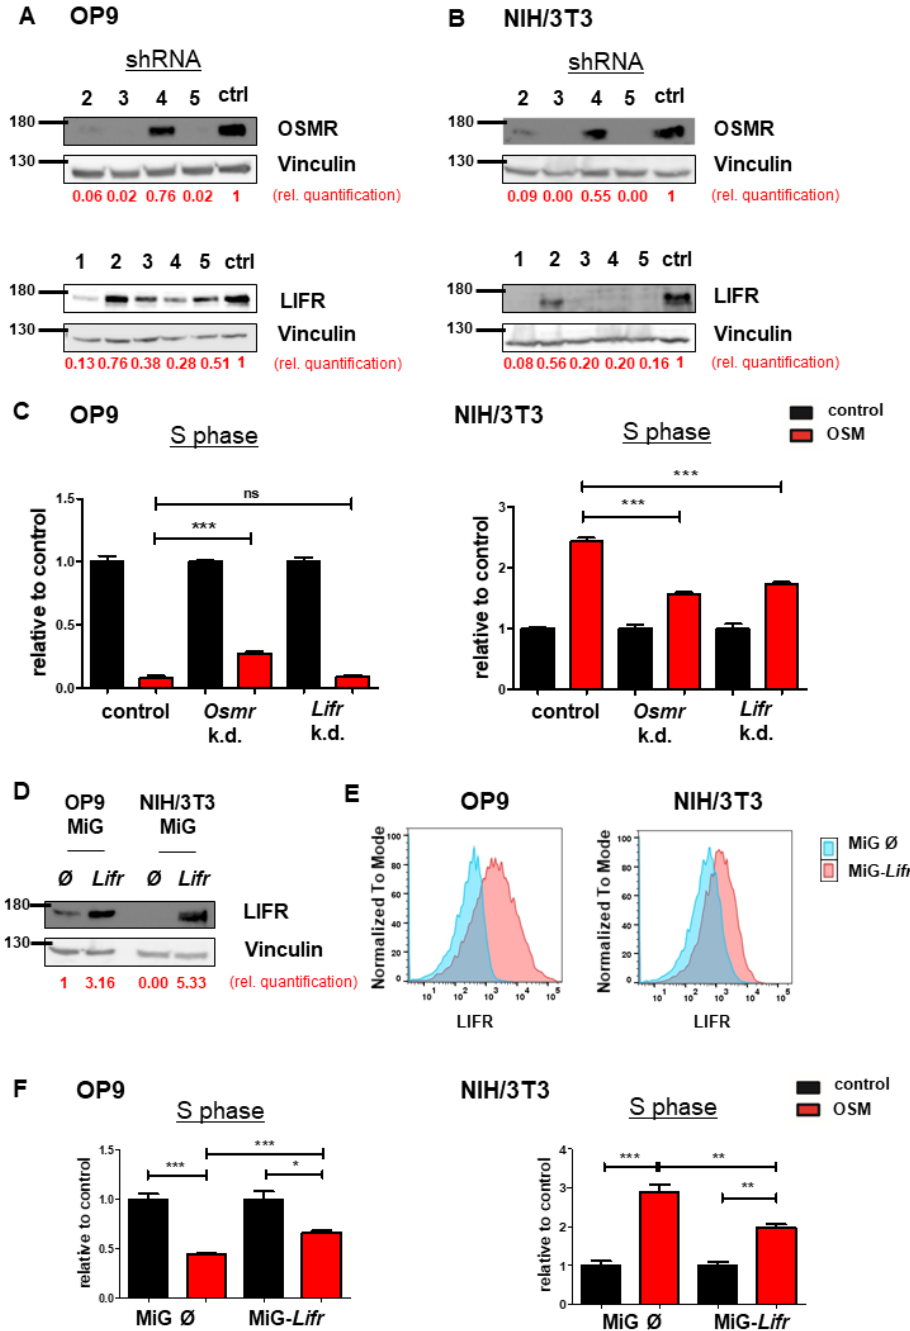
Figure 3. OSMR downregulation attenuates OSM effects on proliferation. ( A , B ) Immunoblot quantifying the shRNA-induced knockdown of Osmr (n = 4) and Lifr (n = 5) in ( A ) OP9 and ( B ) NIH/3T3 cells. The shRNAs Osmr 5 and Lifr 1 were used in subsequent experiments. Protein molecular weight is labeled in kDa. Relative protein quantities are indicated in red. ( C ) Relative quantification of S phase of OP9 and NIH/3T3 cells carrying a knockdown for either Osmr , Lifr, or a Renilla control in presence or absence of 10 ng/mL mOSM. Cell cycle analysis was performed as described before. One-way ANOVA and Bonferroni post-test. *** p < 0.001. ns = not significant. ( D ) Immunoblot quantifying the LIFR overexpression in OP9 and NIH/3T3 cells. Protein molecular weight is labeled in kDa. Relative protein quantities are indicated in red. ( E ) Lifr overexpressing OP9 and NIH/3T3 cells were examined for LIFR surface expression compared to cells carrying the mock control. ( F ) Relative quantification of S phase of OP9 and NIH/3T3 cells transduced with Lifr or empty vector (MiG). Cell cycle analysis was performed as described before. One-way ANOVA and Bonferroni post-test. * p < 0.05, ** p < 0.01, and *** p <